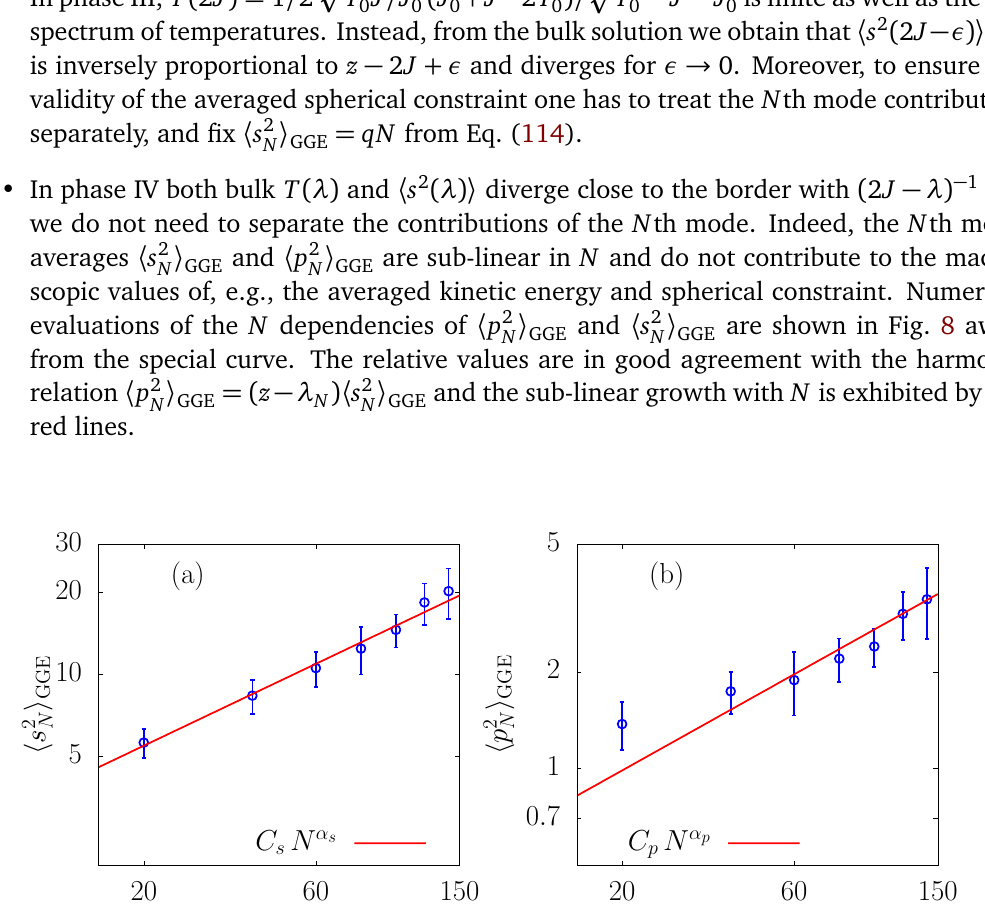
Figure 8: Finite size dependence in phase IV for parameters T J = 0.5 J , which lie away from the special curve T 0 against N and a power law fit to all data points with α against N , together with the power C the data quite satisfactorily, apart from the first data point at N = 20. (A fit to all points including the N = 20 one yields α with the harmonic Ansatz .) The results have been averaged over up to 50 disorder realisations and the error bars represent the variance around the